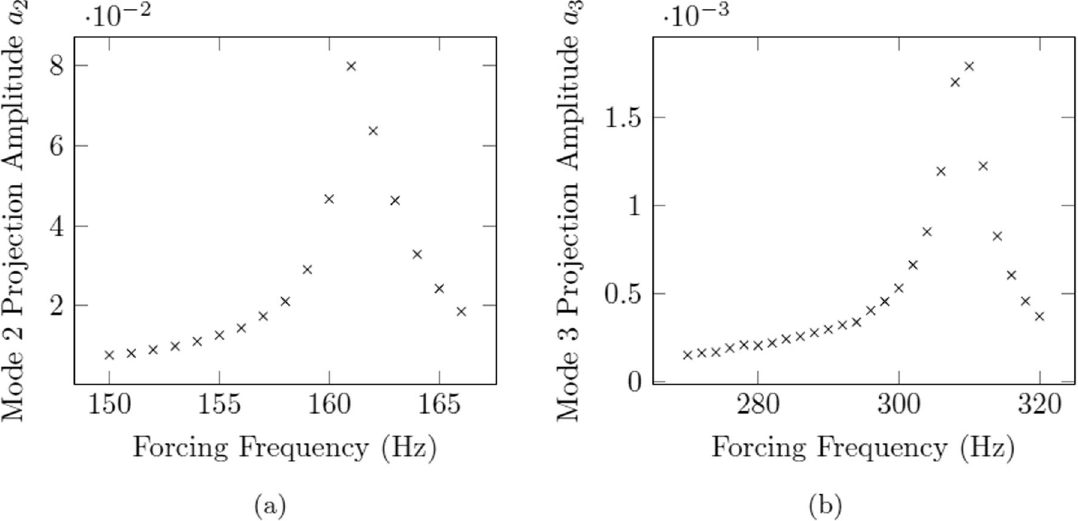
Fig. 11 Example benchmark of results using resonance of both modes 2 and 3. a The resonance curve for mode 2, from which the mode 2 natural frequency is obtained. b The resonance curve for mode 3, from which the mode 3 natural frequency is obtained. Amplitudes a 2 and a 3 correspond to the mean squared projection amplitudes of modes 2 and 3, respectively. The maximum of a n as a function of frequency corresponds to the natural resonant frequency of that mode. Sample is 57.345 mg Inconel 625 at 1350